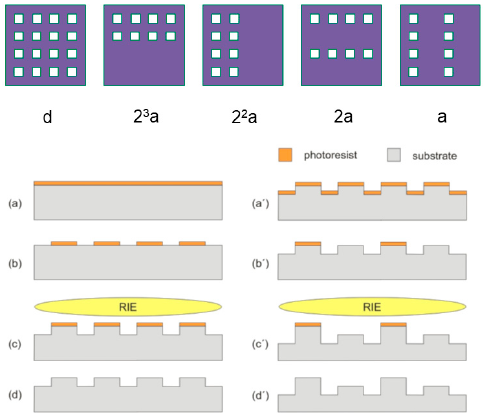
Figure 2. Three-dimensional nanoimprint template fabrication by digital lithography/ etching for a 4 × 4 square array with 16 different heights as an example. ( a – d ) The initial height d is created by the first lithography and etching step of all squares. ( a’-d’ ) Followed by a sequence of four li- thography and etchings steps, Tthe heights range ranging from an the initial height d to (d + 15·a) with the same step a between each other are created., which can be obtained by five lithography and etching steps in sequence. This digital methodology significantly reduces the fabrication steps and saves time and cost, as long as all heights are digital; i.e., they have the identical step or steps with a common divisor. The benefit increases when additional different heights are implemented. The lateral resolution is mainly defined by the lithography resolution. The vertical resolution is much more critical for fabricating 3D templates using the digital etching methodology. It requires rather high accuracy in etching depth control. Otherwise, the errors of the etching processes will accumulate. Digital etching is used for defining the different checkerboard-like arranged sinks of different depths (by nanoimprint translated into a checkerboard-like mesa structure of different heights). Correia et al. [27,28] used digital etching for fabricating the checker- board mesa structure directly and Wang et al. [30] used digital deposition etching for fab-